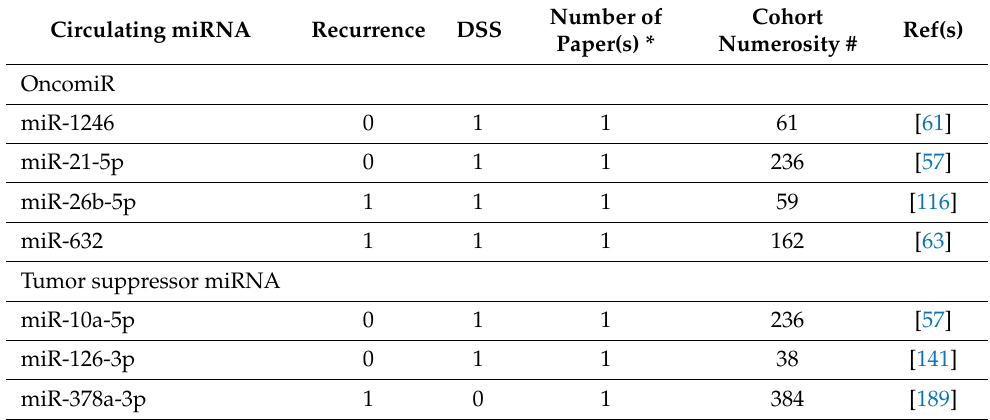
Table 5. Circulating miRNAs associated with prognostic features in LSCC patients. Circulating miRNA